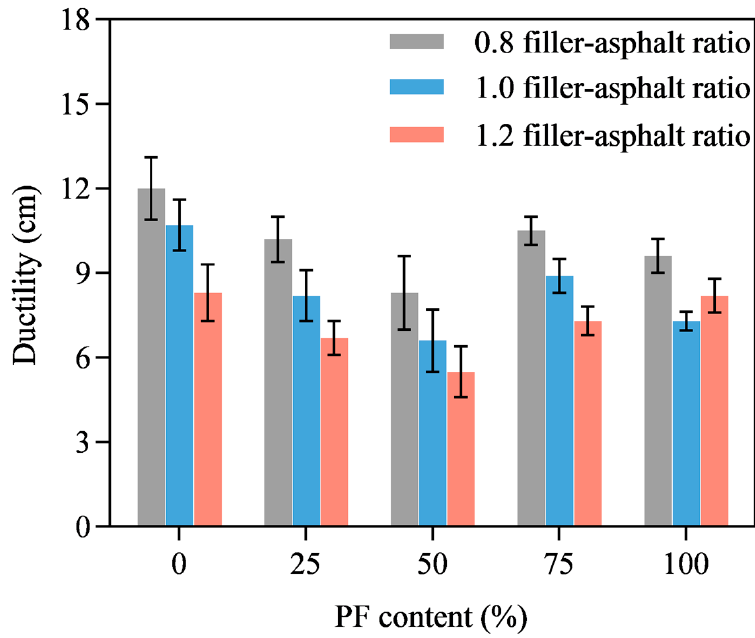
Figure 11. Ductility.